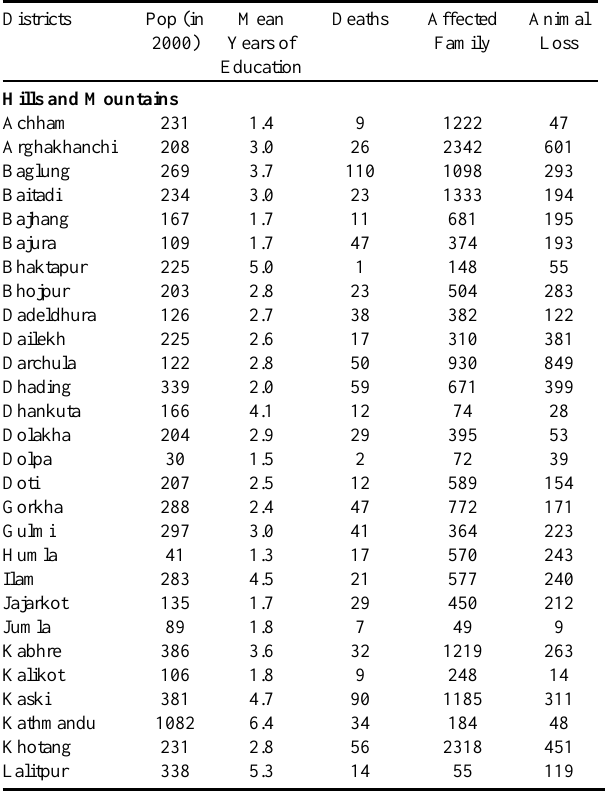
Table 1 . Impact of floods and landslides in all districts of Nepal during 2000-2009 and the size of the population, mean years of schooling in